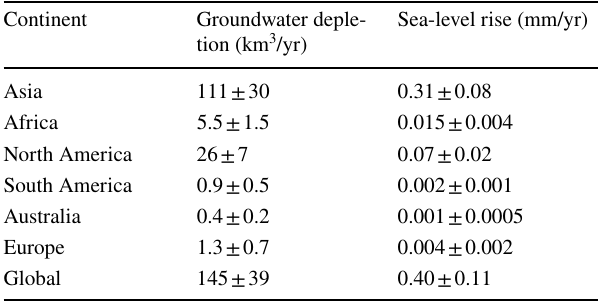
Table 2 Groundwater depletion and SLR estimates over different continents during 2001–08 (Konikow 2011; Taylor et al.